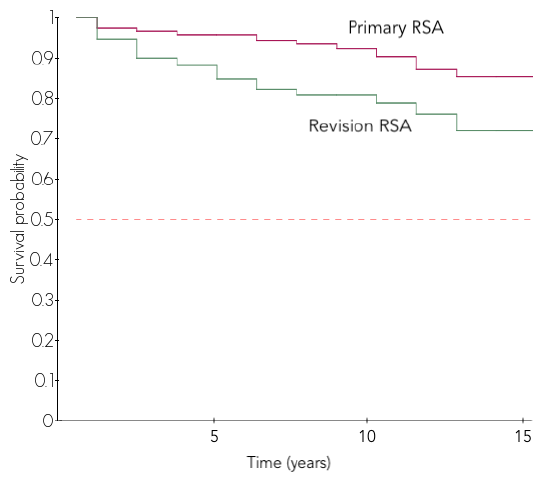
Figure 1. Revision-free survival in primary RSA and revision RSA.